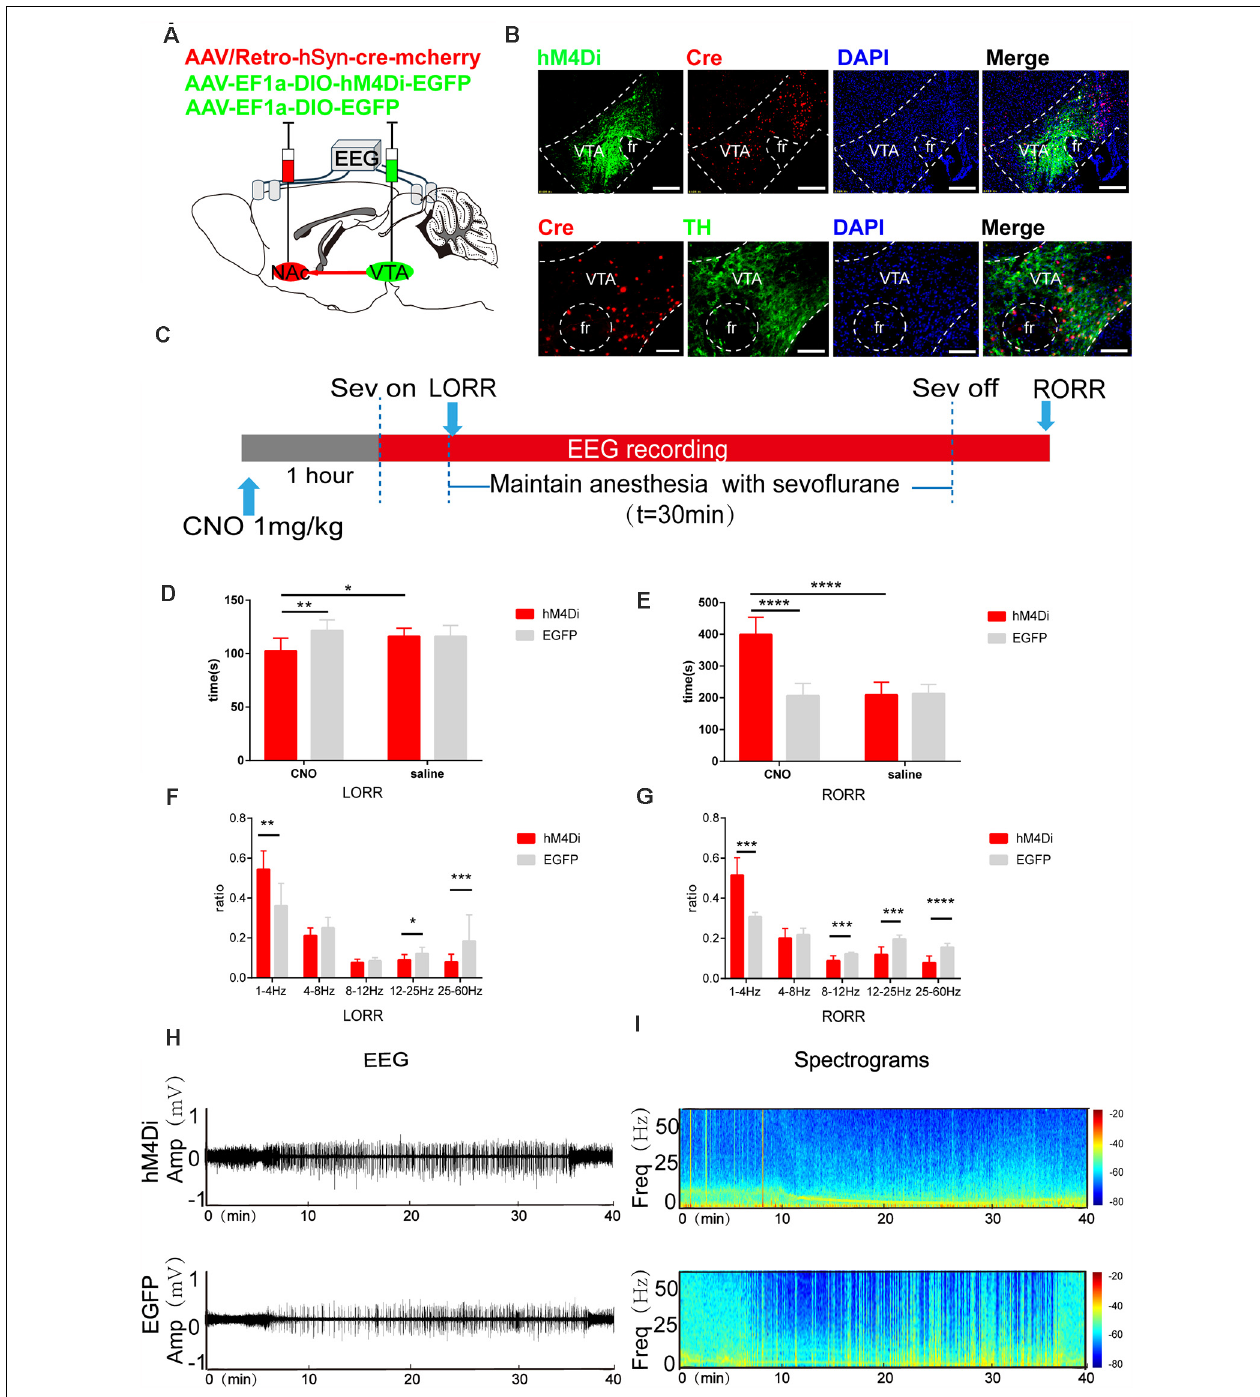
FIGURE 6 | Chemogenetic inhibition of the VTA-NAc pathway regulates the induction and emergence processes of sevoflurane anesthesia. (A) Schematic of the experimental protocol. Cre-dependent hM4Di was injected into the VTA of mice, while retrograde cre was injected into the NAc. (B) Expression of hM4Di-EGFP (green) and retrograde cre-mCherry (red) in the VTA and NAc shows dopaminergic projections from the VTA to the NAc in the mouse brain (above). Scale bars: 200 µ m. Immunofluorescence of cre-mCherry (red) and TH (green) in the VTA (below). Scale bars: 100 µ m. (C) Experimental timeline of the behavioral test and EEG recording. (D) CNO-mediated hM4Di inhibition notably reduced the LORR time. (E) CNO-mediated hM4Di inhibition significantly prolonged the RORR time. (F) CNO-mediated inhibition increased the ratio of the δ band but reduced the ratio of the β and γ bands during LORR. (G) CNO-mediated inhibition led to an increased power of the δ band and decreased powers of the α , β and γ bands during RORR. (H,I) Representative EEG traces and heat map from the two groups. CNO: clozapine N-oxide. Data are presented as the mean ± SD. * p < 0.05, ** p < 0.01, *** p < 0.001 and **** p < 0.0001, n = 8, by paired and unpaired t -test.